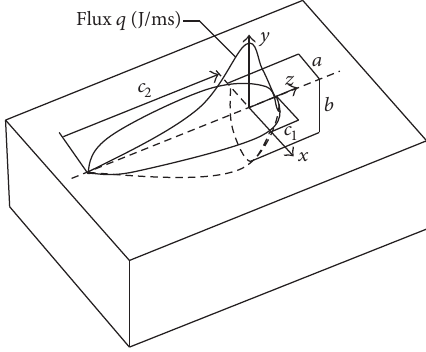
Figure 10: Double-ellipsoid heat